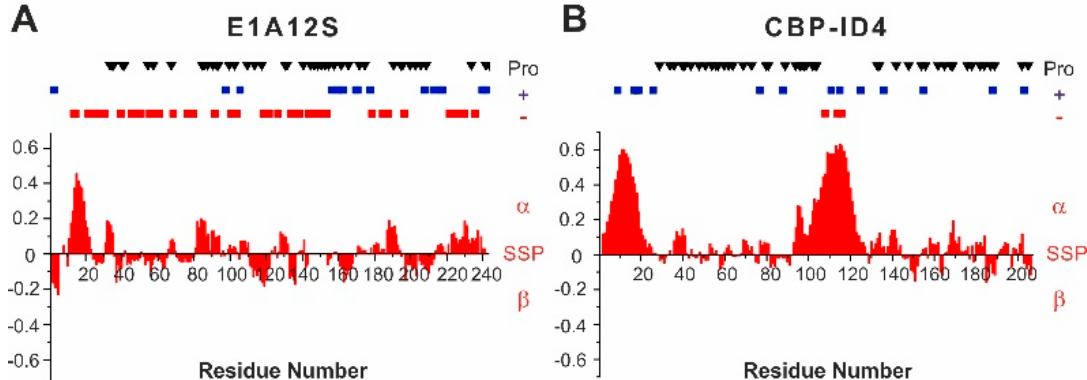
Figure 2. Secondary structure propensity of E1A12S ( A ) and CBP-ID4 ( B ). Proline residues are highlighted along the protein sequence as black triangles. Positive residues are highlighted as blue squares, negative residues are highlighted as red squares.